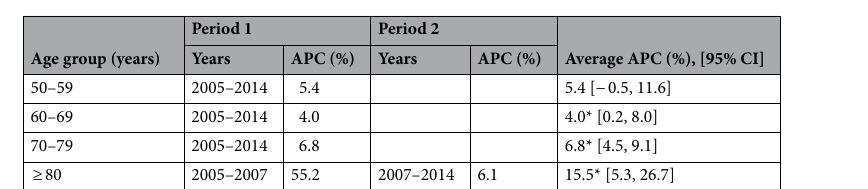
Table 2. Trends in the annual crude and age-adjusted incidence rate of Creutzfeldt–Jakob disease per 1,000,000 population aged ≥ 50 years by age group, 2005–2014. Within each age group, periods were separated as Period 1 and Period 2 when the trend changes were statistically detected in the joinpoint regression analysis during the study period. AAR age-adjusted rate, APC annual percentage change, CI confidence interval. *Significantly different from zero ( p <